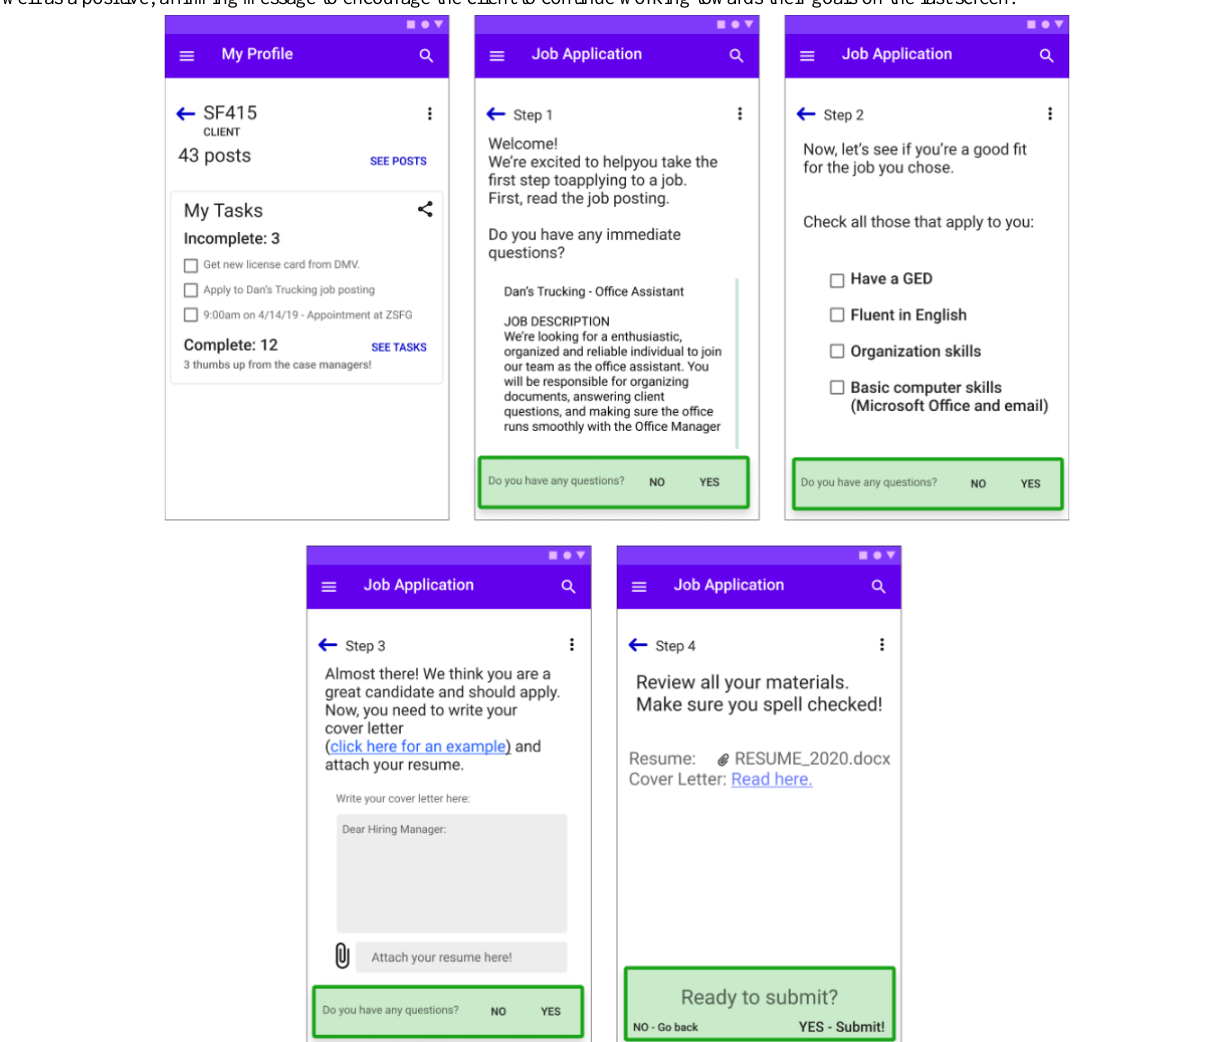
Figure 4. Proposed depiction of a mobile application wireframe showing a job application workflow. The client begins with a list of incomplete and complete tasks on the first screen. The screens Step 1 through Step 4 detail the step-by-step process of applying for a job, with options to ask